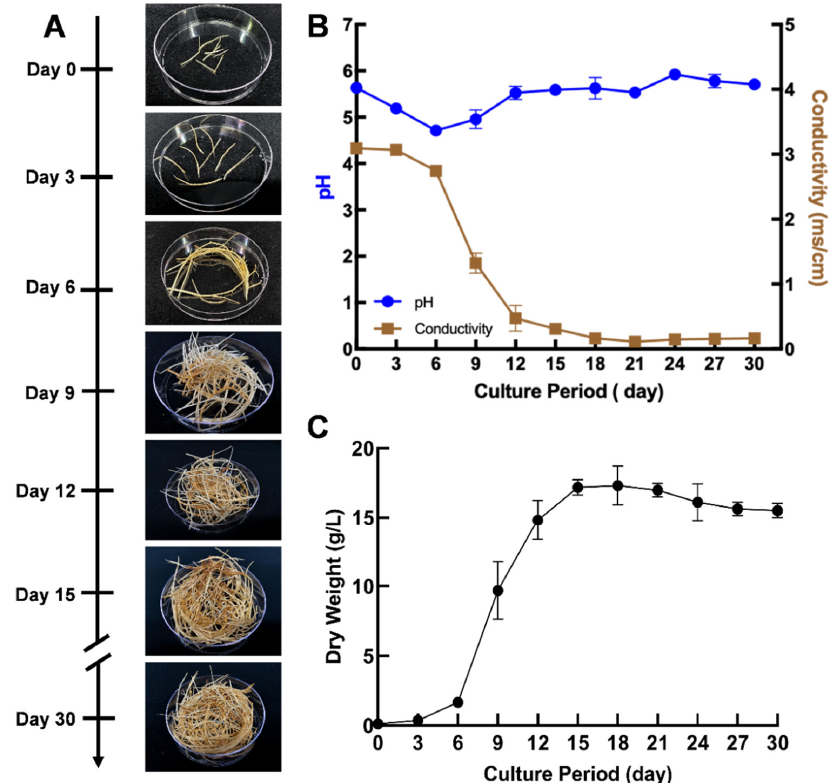
Figure 2. Growth of pigeon pea hairy root line G4. ( A ) Phenotype of pigeon pea hairy roots during the 30-day culture period. Pictures are representative of triplicate cultures. ( B ) Conductivity (brown) and pH of the medium (blue) at different stages of growth. ( C ) Growth curve of the hairy roots. Values represent the average of three biological replicates and the error bar represents standard deviation.